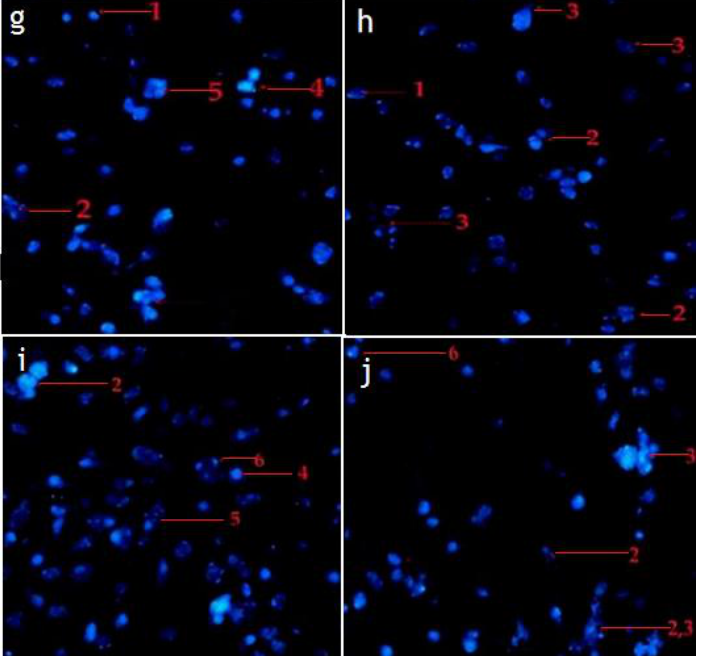
Figure 8. Representative photomicrograph showing the morphological changes of RMS cancer cells. RMS cells treated with hexane fraction of C. minima (( g ): 37.5 μg/mL; ( h ): 75 μg/mL); and chloroform fraction of C. minima ( i ): 45 μg/mL; ( j ): 90 μg/mL) for 24 h and imaged by Hoechst 33342 staining method (magnification 200×).